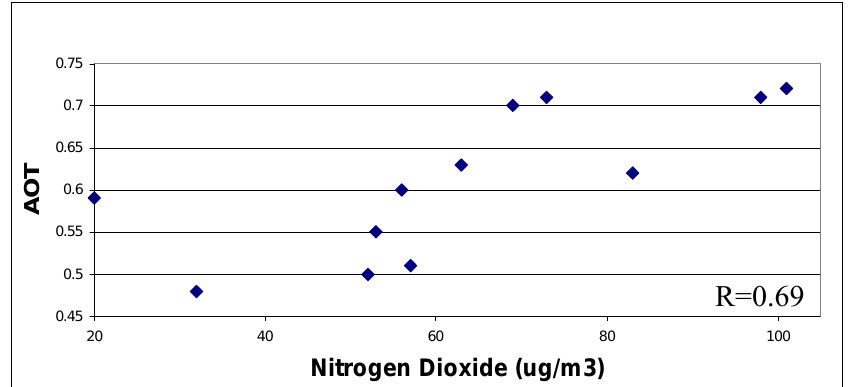
Figure 6 . Relationship between AOT and NO hour of image time for the three image